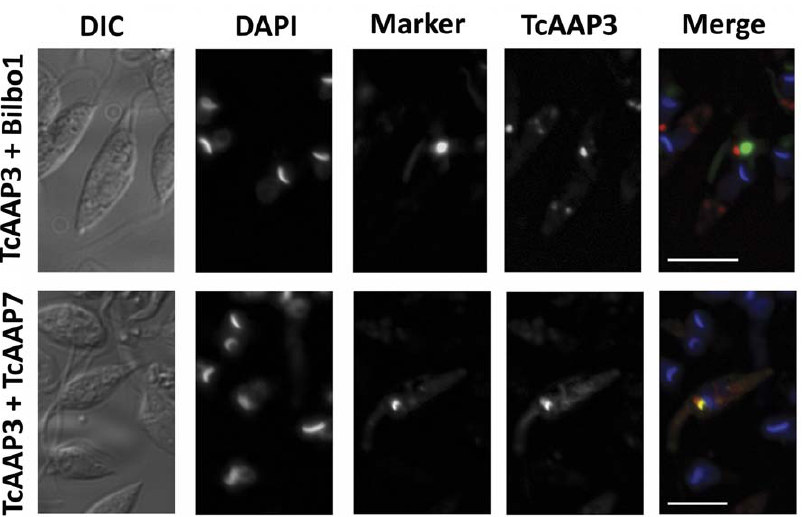
Figure 4. Subcellular localization of TcAAP3. Parasites co-transfected with the pTREXL-mCherry::TcAAP3 and pTREXL-Bilbo1::eGFP (upper panels) or pTREXL-eGFP::TcAAP7 (lower panels) were analyzed by fluorescence microscopy, 24 h post-transfection. Differential interference contrast (DIC), DAPI, eGFP (Marker), mCherry (TcAAP3) and the merged image (Merge) are showed in the indicated columns. White bars in the left corner of the merged images represent 5 m